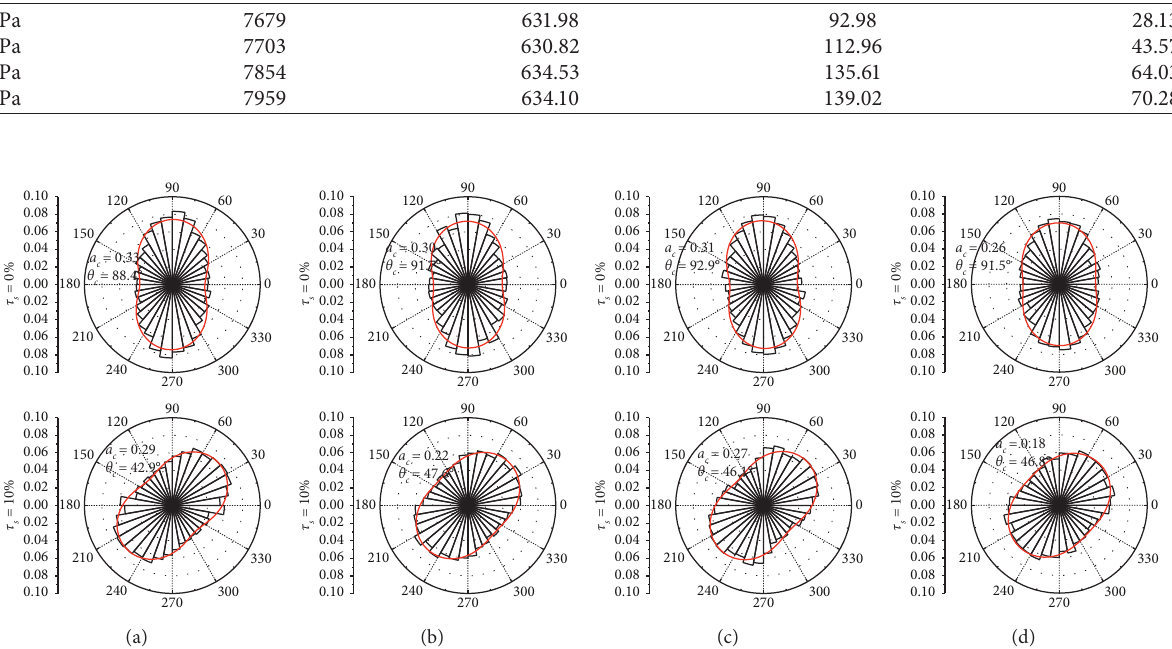
� 15kPa; (b) σ � 35kPa; (c) σ � 55kPa; (d) σ � n n n